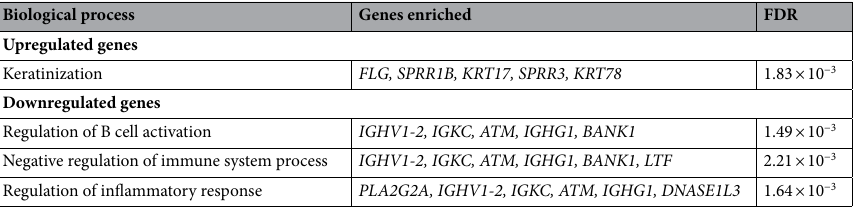
Table 4. List of enriched biological processes in